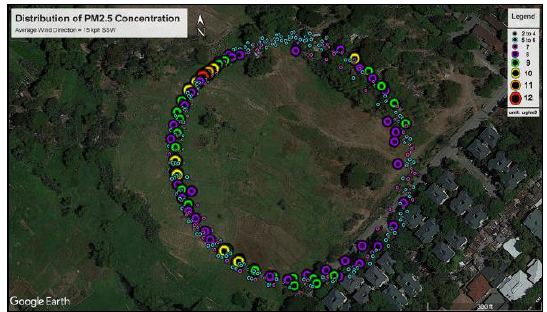
Figure 18. Horizontal Distribution of PM 2.5 Concentration in the study area